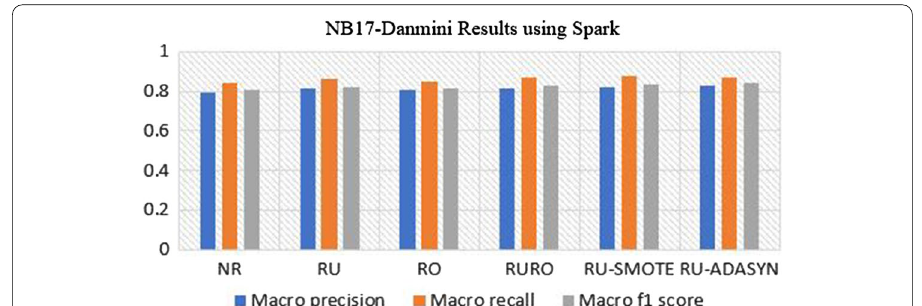
Fig. 15 ANN classification results for NB17-Danmini on AWS with Spark for various resampling